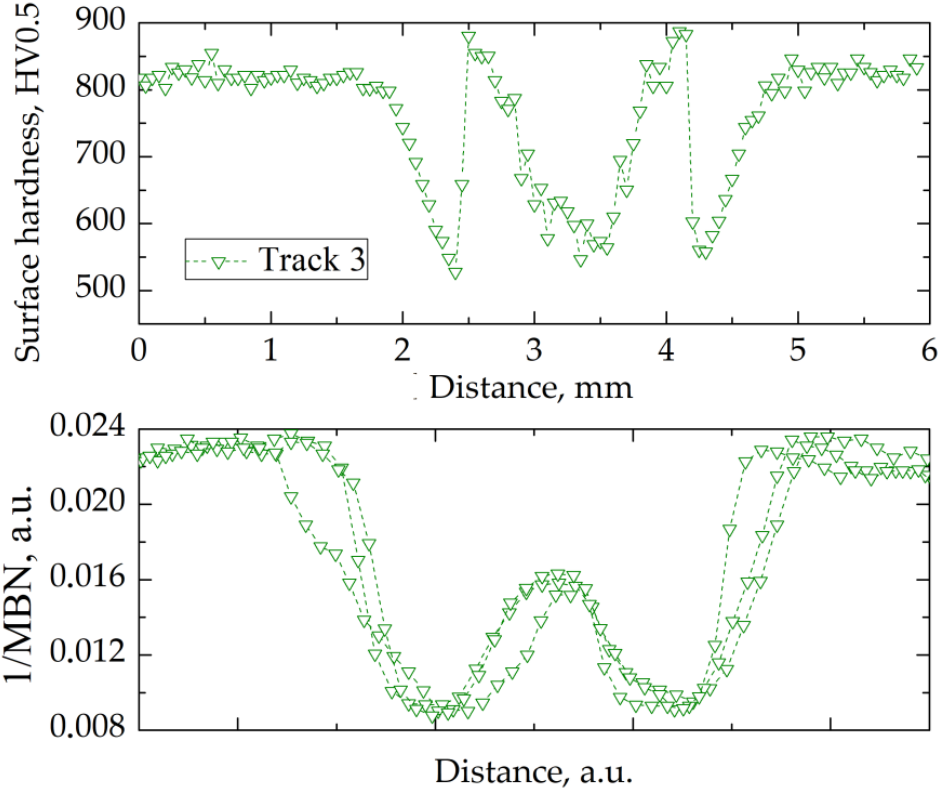
Figure 12. Relation between hardness (upper panel) and normalized 1/MBN (lower panel) as a function of distance (surface coordinate) across the laser-processed track 3.